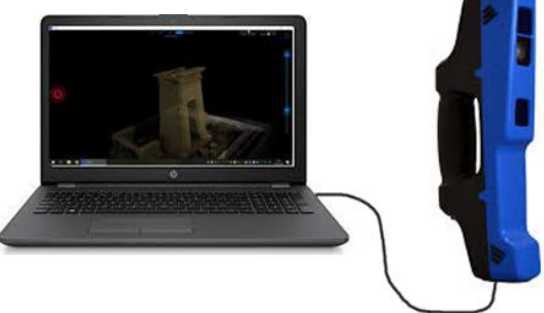
Figure 4. The F6 SR by Stonex connected via cable to a PC